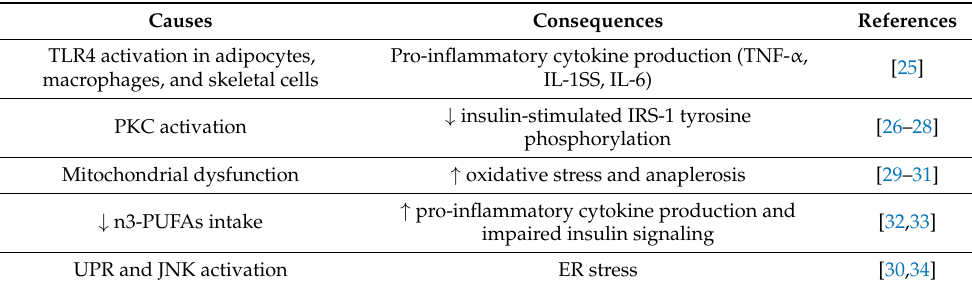
Table 2. Mechanisms proposed to explain insulin resistance induced by